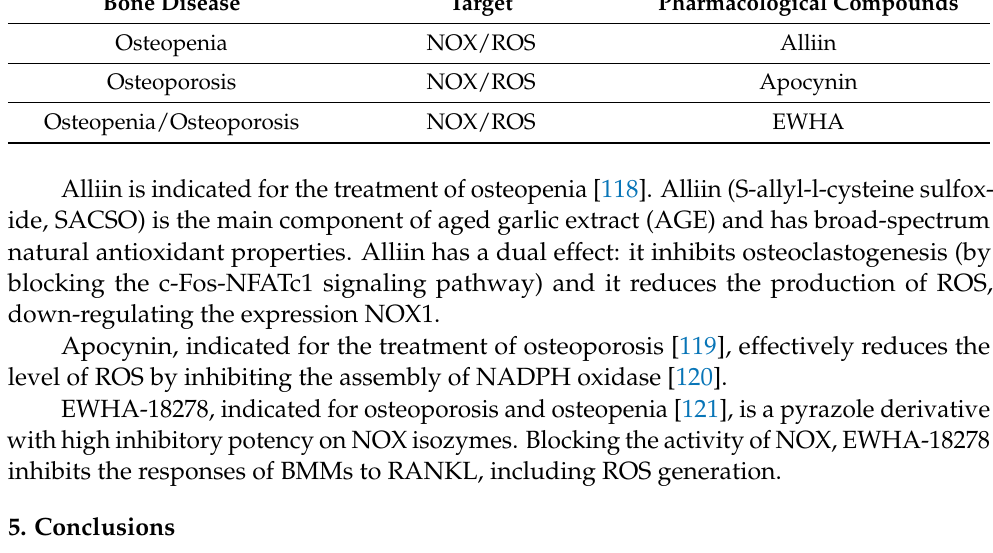
Table 1. Pharmacological compounds, which mainly act by inhibiting NOX complex activation and ROS production. Bone Disease Target Pharmacological Compounds Osteopenia NOX/ROS Alliin Osteoporosis NOX/ROS Apocynin Osteopenia/Osteoporosis NOX/ROS EWHA Alliin is indicated for the treatment of osteopenia [118]. Alliin (S-allyl-l-cysteine